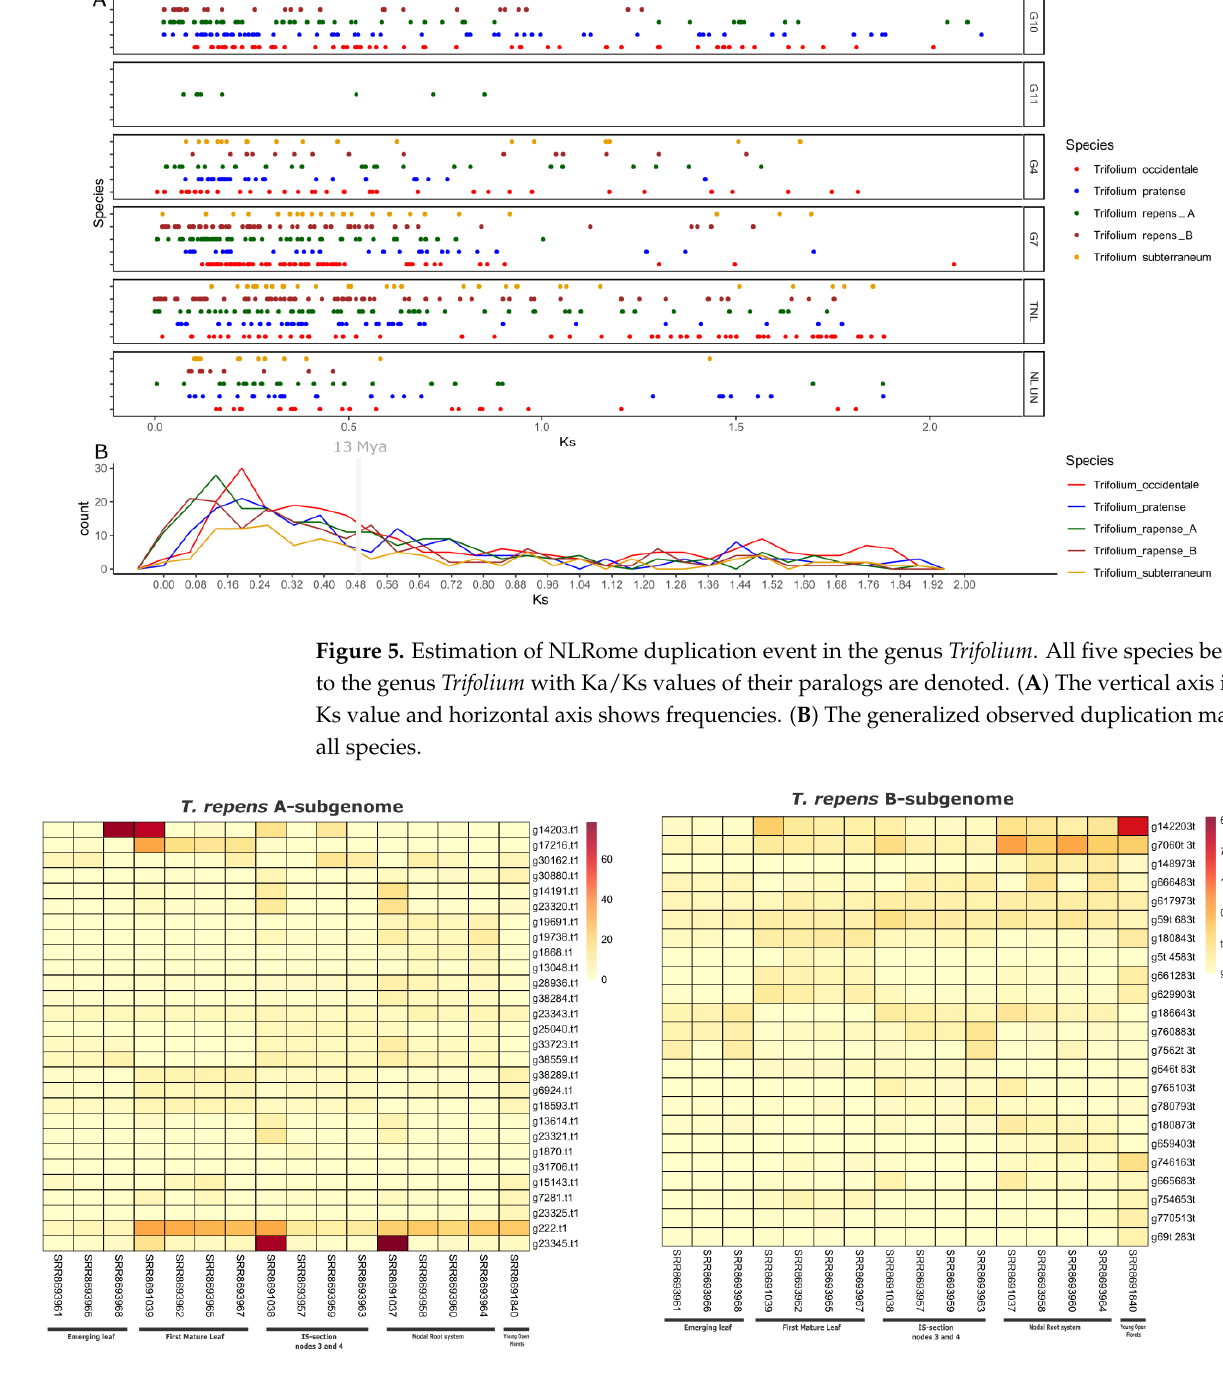
Figure 6. Comparative transcriptomic analysis between subgenomes–A and B of T. repens during five different development stages. Left panel shows the expression of 29 different NLR genes in subgenome-A, whereas right panel shows the expression of 23 NLR genes in subgenome-B of T. repens .